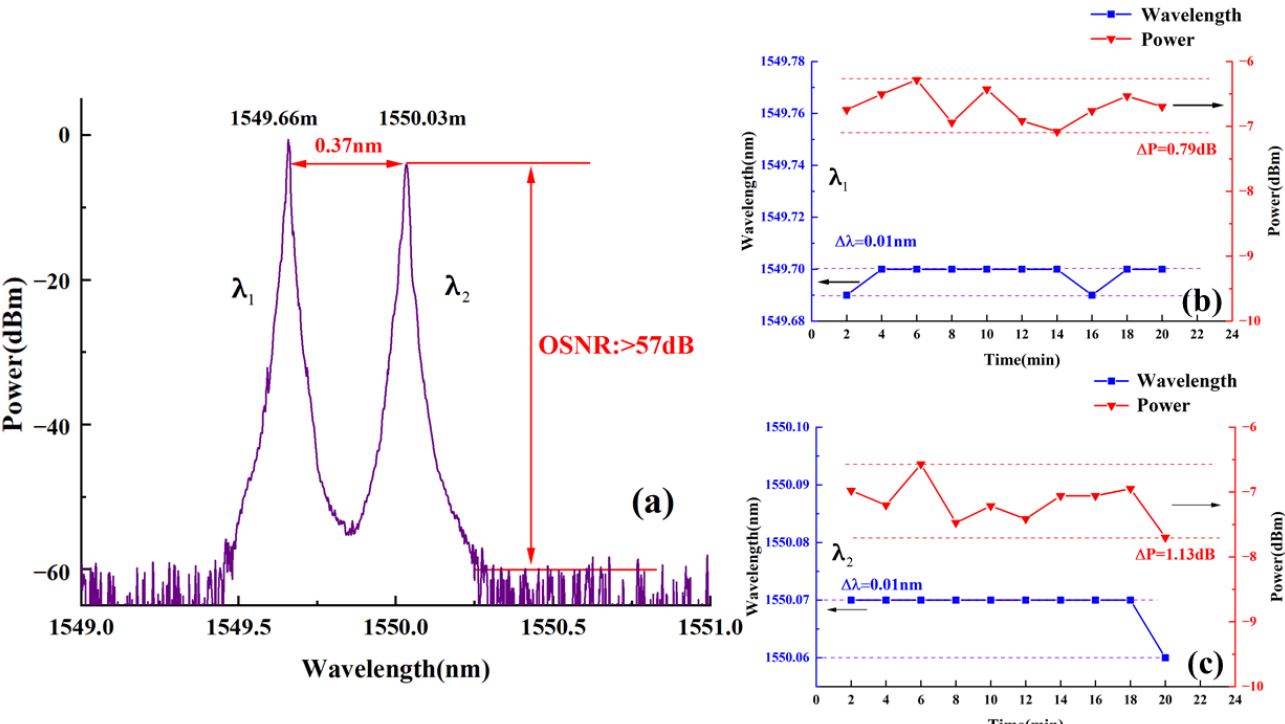
Figure 5. ( a ) Dual wavelength operating spectrum measured by the OSA at 400 mW pump power; ( b , c ) the variation in the lasing output’s power intensity and the wavelength during 0.5 h.